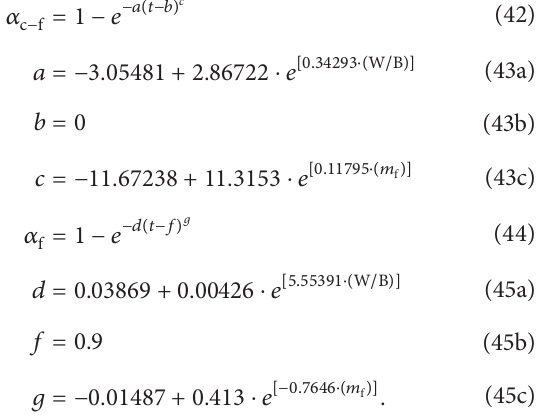
Figure 8: Influence of the W/B ratio on the increased degree of cement hydration.